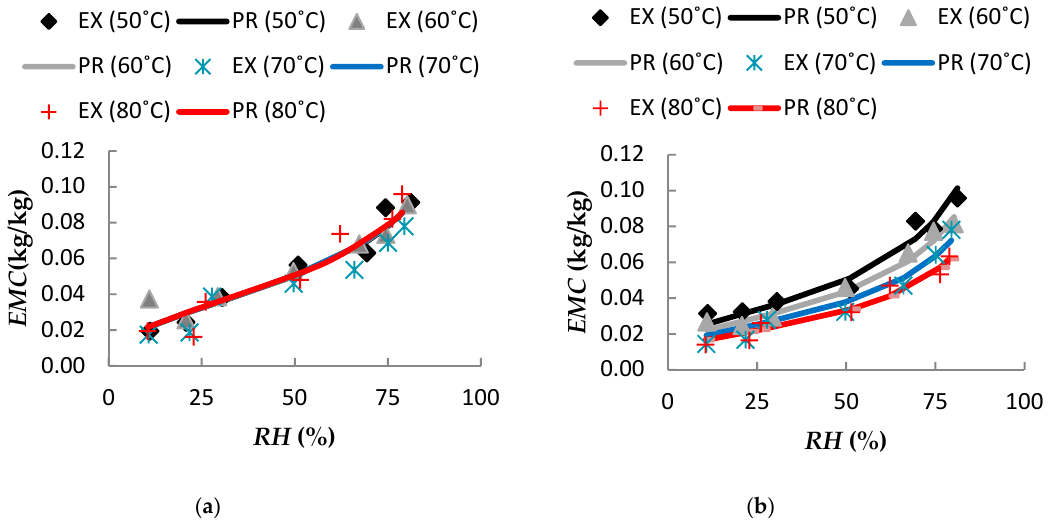
Figure 10. Experimental and predicted desorption isotherms for whole and ground palm kernel using modified Oswin model ( a ) and modified Halsey ( b ), respectively.